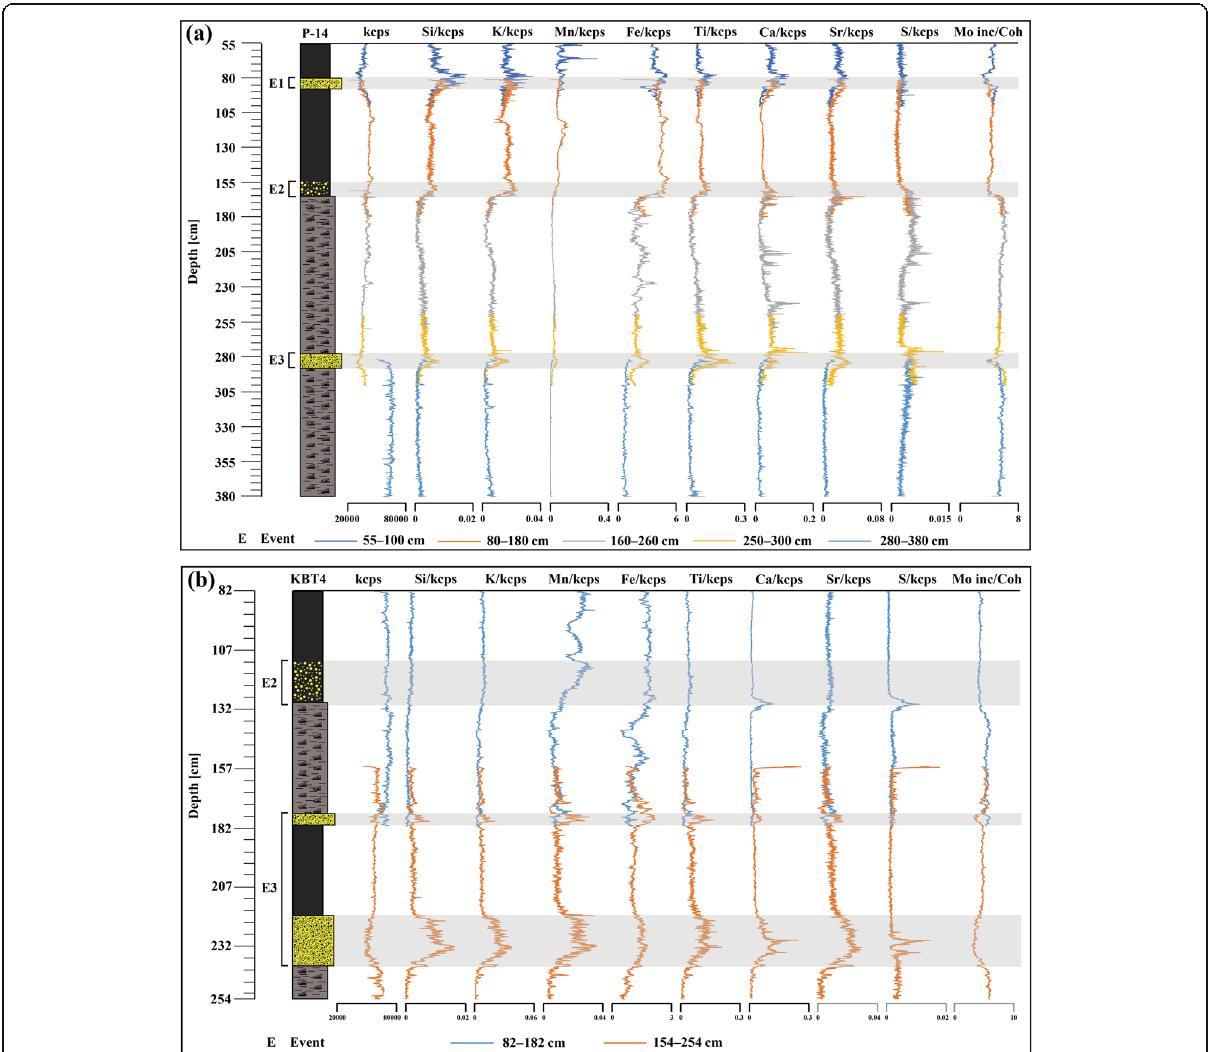
Fig. 7 Normalized ITRAX XRF data of ( a ) P-14 core (55 – 380 cm depth) and of ( b ) KBT4 core (82 – 254 cm depth). Gray-shaded bars represent depths of the respective sand